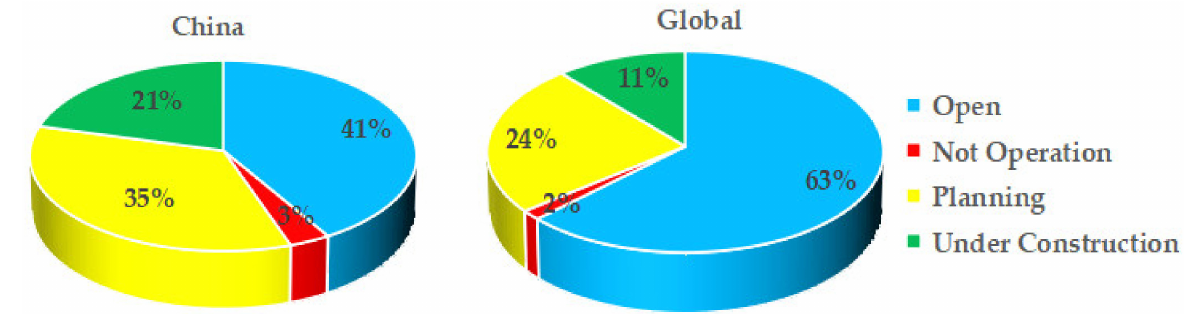
Figure 1. Structure diagram of HRSs in China and Global by the end of 2021